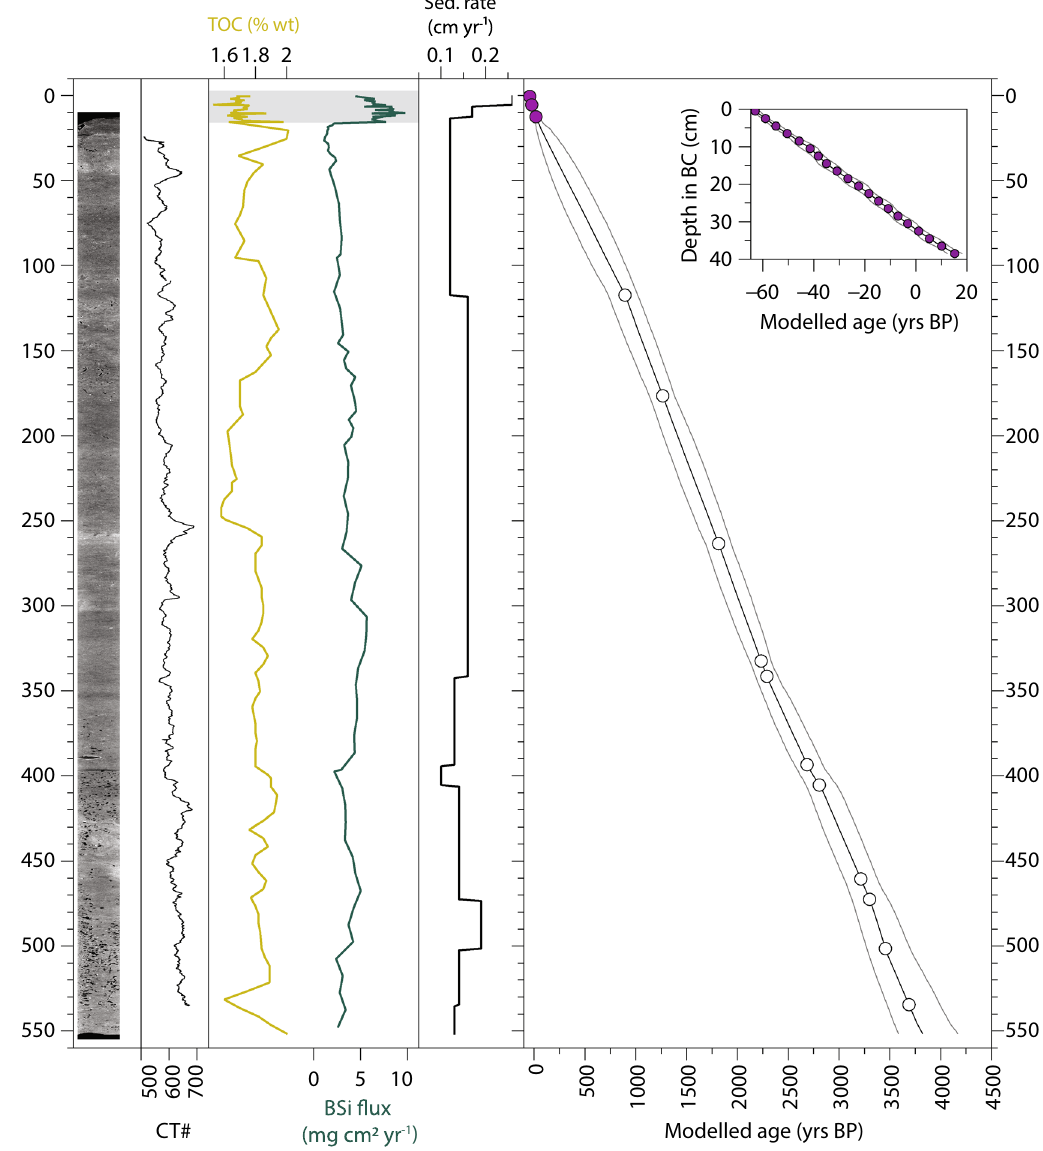
Figure 4. Physical and selected biogeochemical sediment properties and age-depth model for CASQ1 BC and CASQ1. From left to right: CASQ1 Computerised tomography (CT) scan image and CT number (#). Denser areas appear whiter in the CT scan image. Percentage (weight) of total organic carbon (TOC; yellow) and biogenic silica fluxes (BSi; dark green). Calculated sedimentation rates (cm yr -1 ) are shown in black. The median age (modelled) -depth relationship constructed in BACON for CASQ1 and CASQ1 BC (insert) are shown with purple-filled circles representing 210 Pb-dated intervals and open circles the 14 C-dated intervals (biogenic carbonate). The solid black line indicates the median modelled age-depth relationship and the grey dashed lines indicate maximum and minimum modelled ages in the 95% confidence interval. . The grey bar indicates the stratigraphic interval where CASQ1 BC and CASQ1 proxies